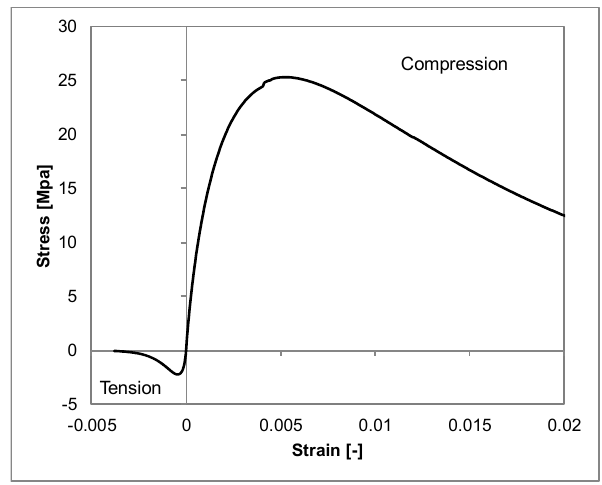
Figure 7. Geometry of specimen [37,38] used for validation and FE modeling approach.